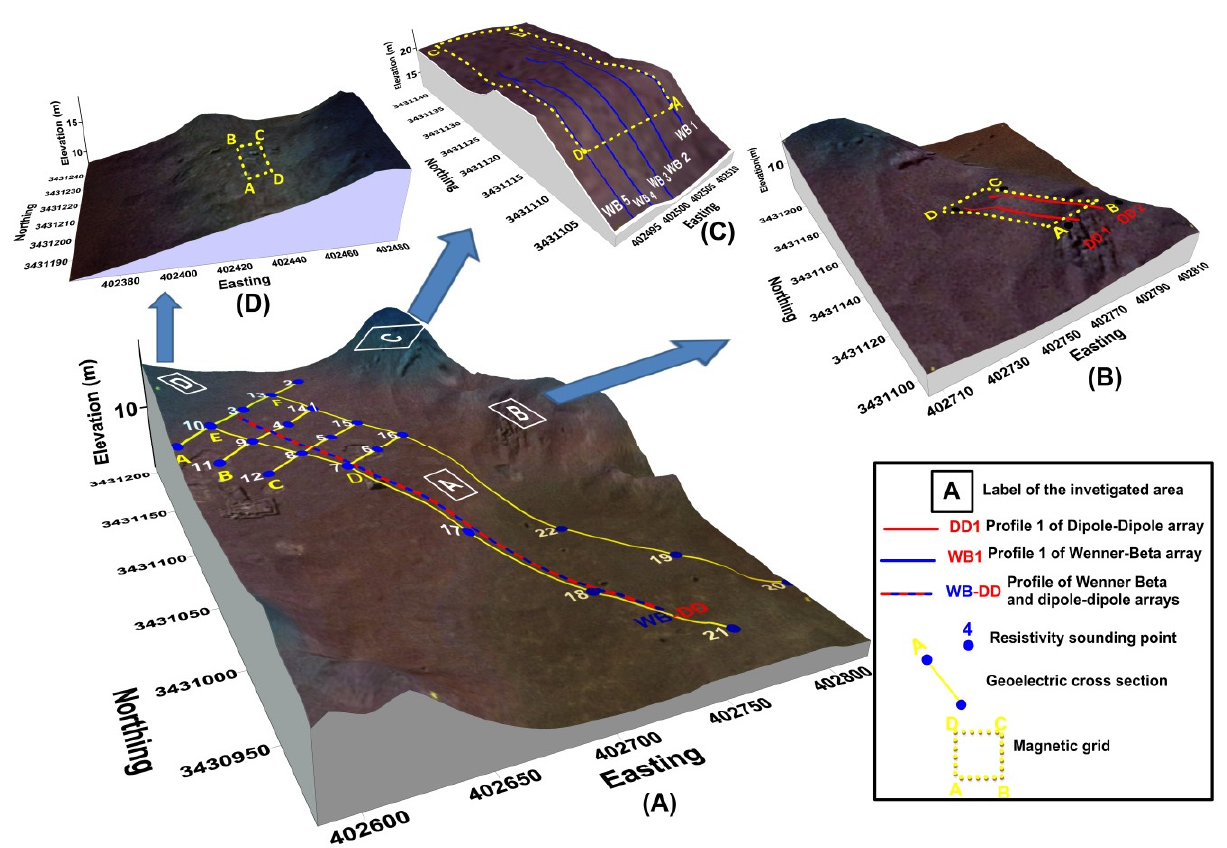
Figure 3. 3D surface maps of the investigated sites showing the geophysical survey layout: ( A ) heart of the Tell; ( B ) eastern periphery; ( C ) northeastern hill; and ( D ) western hill. Table 1. The geophysical survey measurements and field parameters at all investigated sites. Geophysical surveys